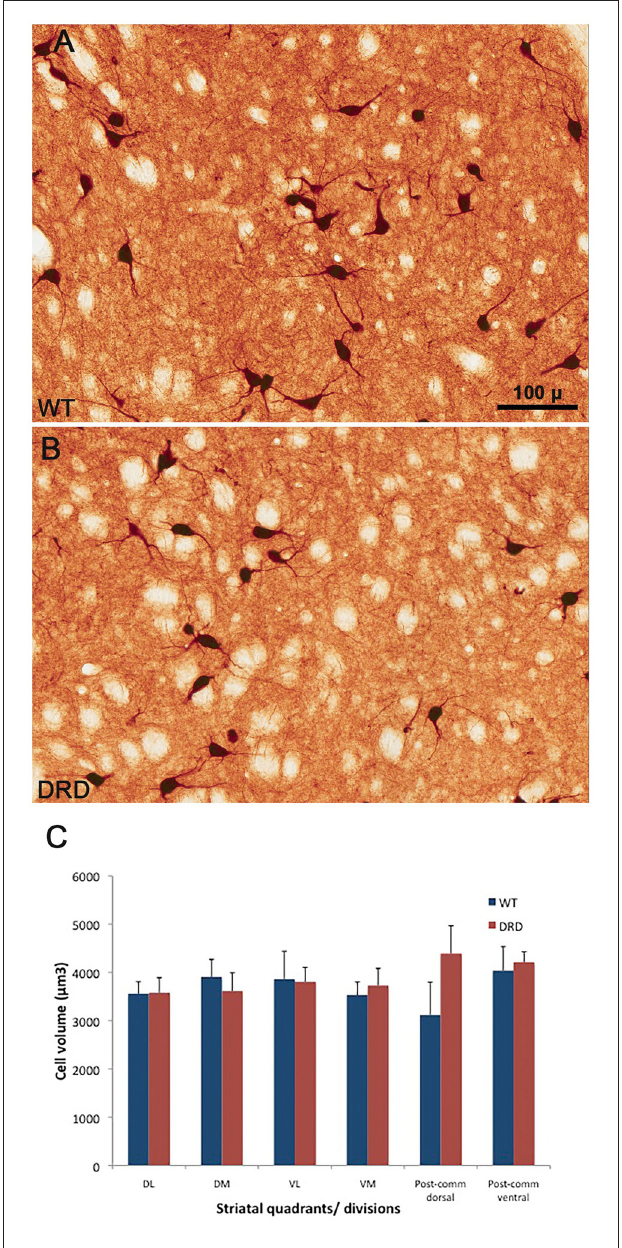
FIGURE 5 | (A–C) High power views of ChAT-positive neurons in the DS of a WT (A) and a DRD (B) mouse to depict the morphological features of cholinergic interneurons (ChIs) between the two animal groups. (C) Compares the average ( ± SEM) volume of ChAT-immunoreactive perikarya measured from the different striatal regions of interest depicted in Figure 1 . Three WT and three DRD mice were used in this analysis. The volume of 20 randomly selected striatal ChIs was measured in each mouse. No significant difference in ChIs perikaryal volume was found between the two animal groups in any of the striatal regions